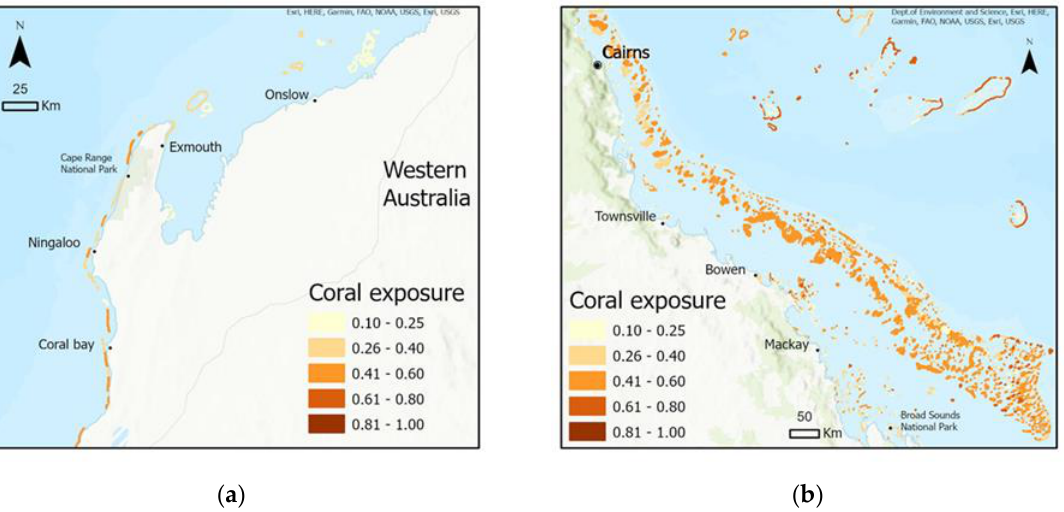
Figure 7. Coral exposure index maps are calculated by equally weighting the two exposure indicators for the Ningaloo Reef ( a ) and the southern Great Barrier Reef ( b ). Higher (darker) values denote higher exposure.